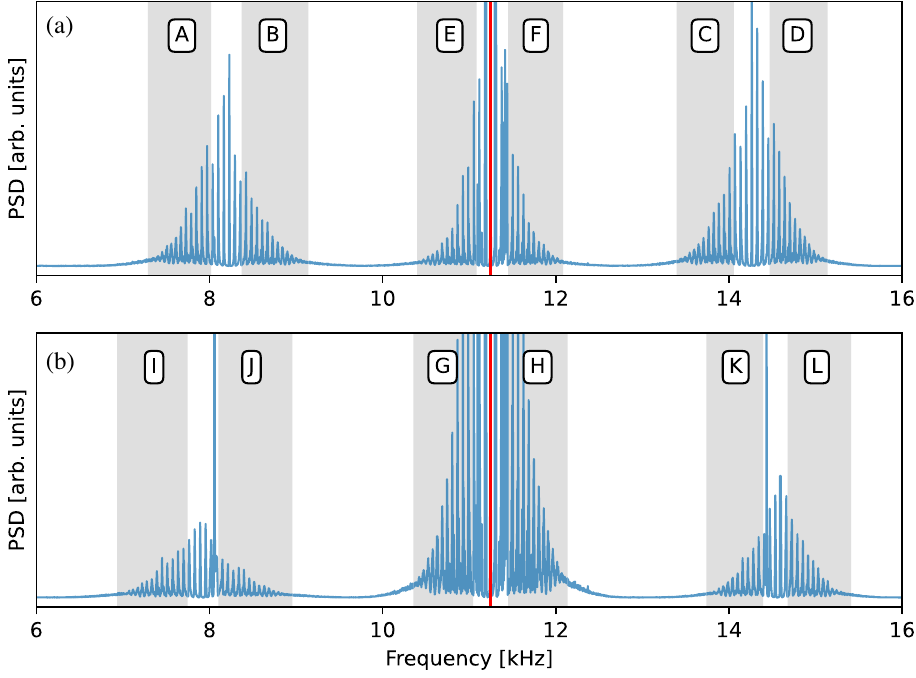
FIG. 3. Gray shaded regions show the frequency ranges used in the fitting procedure of the horizontal (a) and the vertical (b) Schottky spectra for LHC fill 7435. The red vertical line denotes the harmonic of the revolution